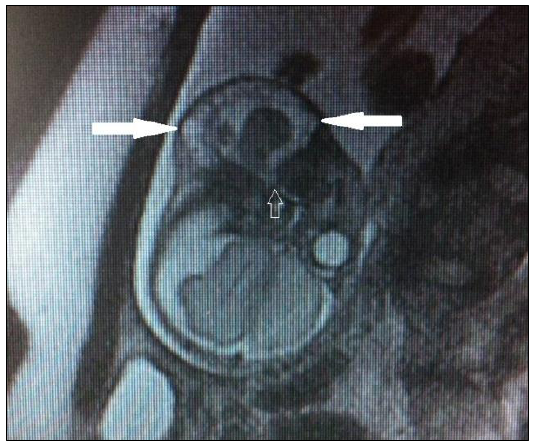
Figure 1: Fetal MRI showing a cervico-mandibular